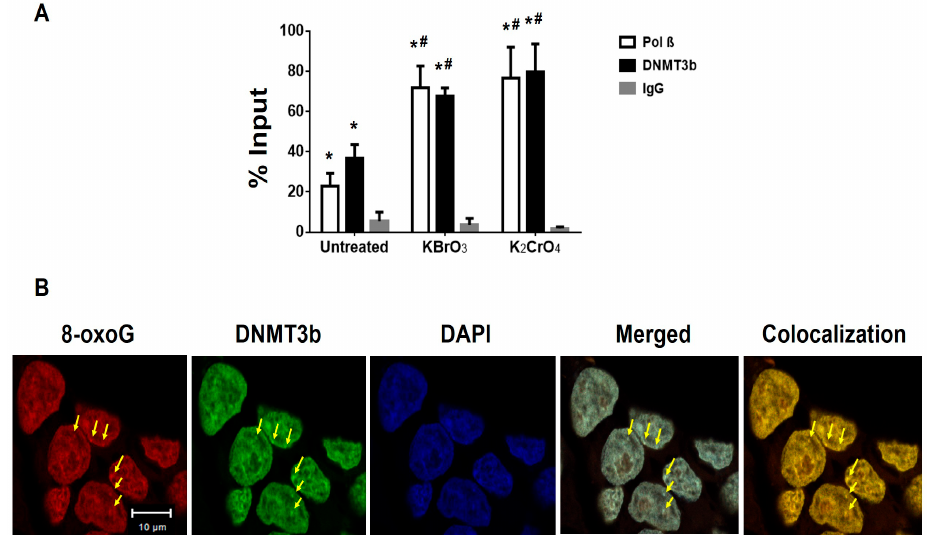
Figure 3. Pol β is recruited to 8-oxoGs in cells: Micro-irradiation was employed to induce 8-oxoGs in HEK293H cells that were transfected with a plasmid expressing mCherry-tagged human pol β . Pol β -mCherry was recruited (red), and 8-oxoG stained with an anti-8-oxoG antibody (green) was generated 4 min after micro-irradiation damage. The nucleus was stained with DAPI (blue). The experiments were done in triplicate.